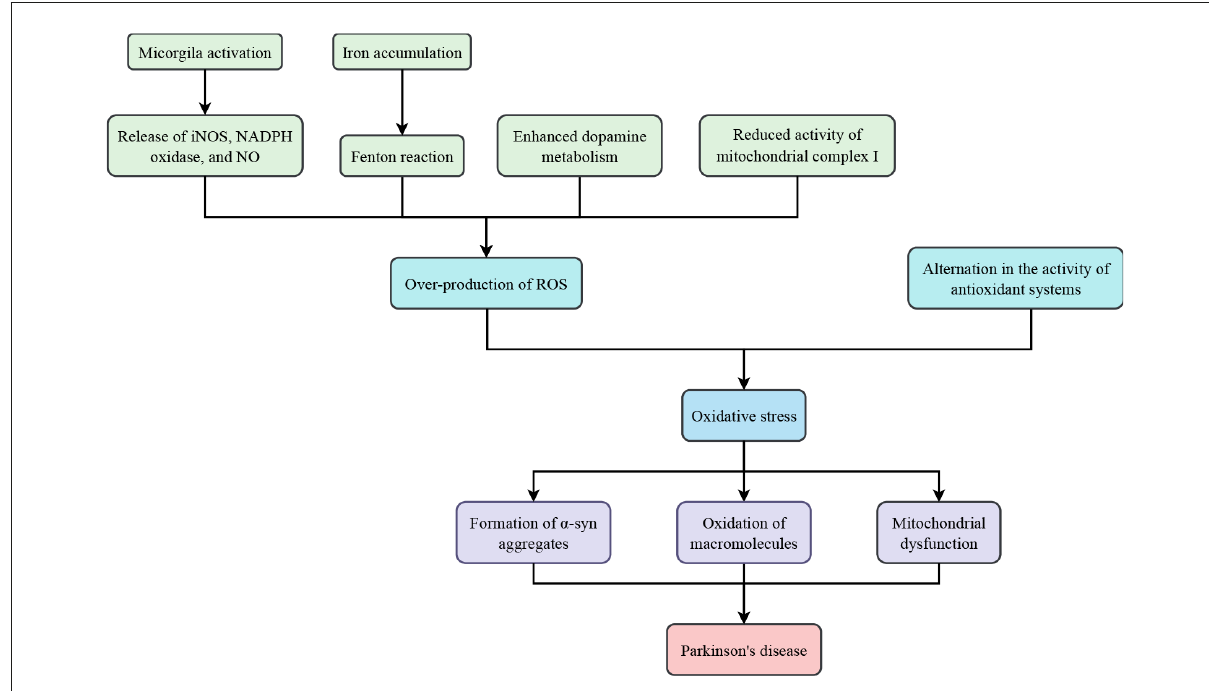
FIGURE1 Oxidative stress in Parkinson’s